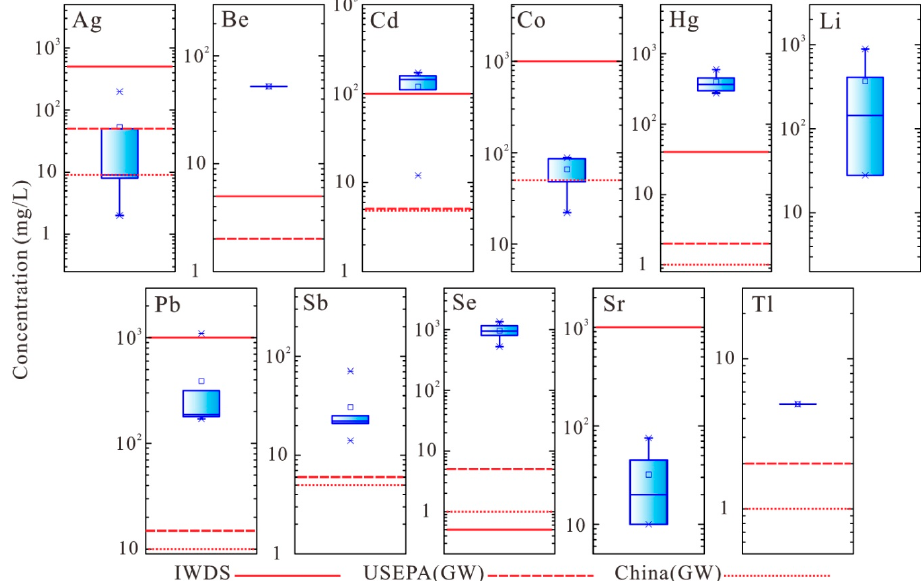
Figure 5. Boxplot of the concentration of trace elements in red mud leachate (Red lines indicates the MCLs of groundwater quality